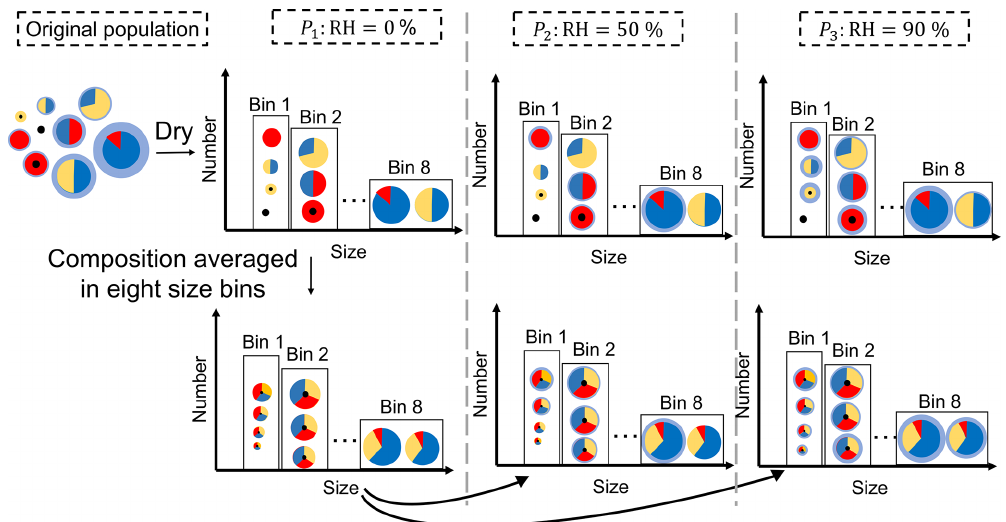
Figure 1. Conceptual framework of composition averaging. The colors indicate different aerosol species. Light blue stands for water, and black stands for black carbon. The other colors conceptually represent other chemical species. In total, we track 18 aerosol species in addition to BC and water. Composition averaging is applied to the dry populations, and then water uptake is recalculated for RH = 50% and RH = 90%. The composition averaging procedure conserves bulk mass concentration of each species, the total number concentration and the particle diameters within each bin.